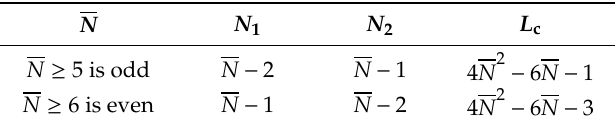
Table 1. Relationship among N , N 1 , N 2 , and L c for the proposed four kinds of novel nested arrays (NNAs). N N 1 N 2 L c N ≥ 5 is